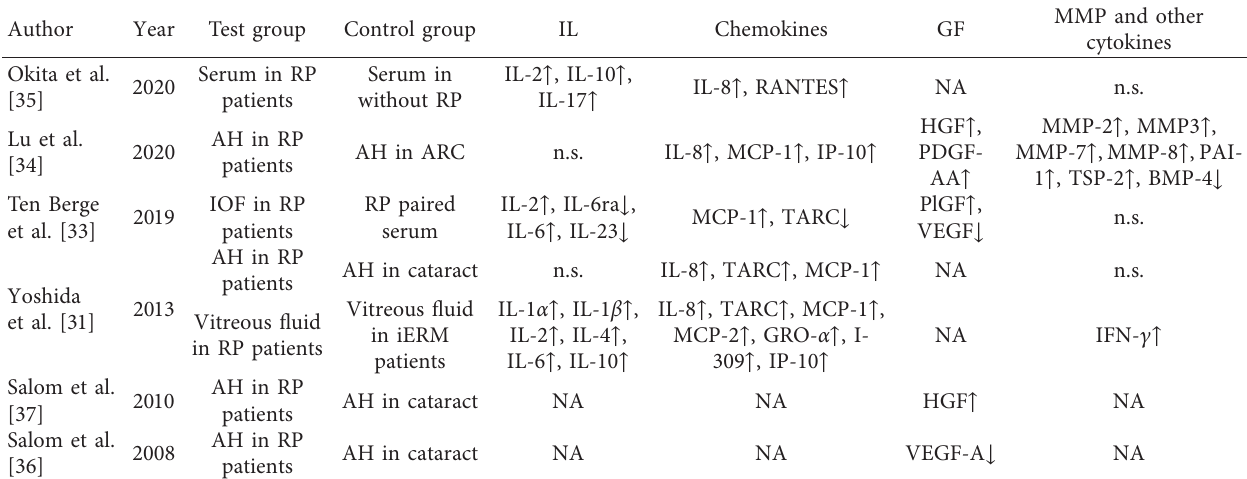
Table 1: Changes of cytokines between RP patients and the control group in different